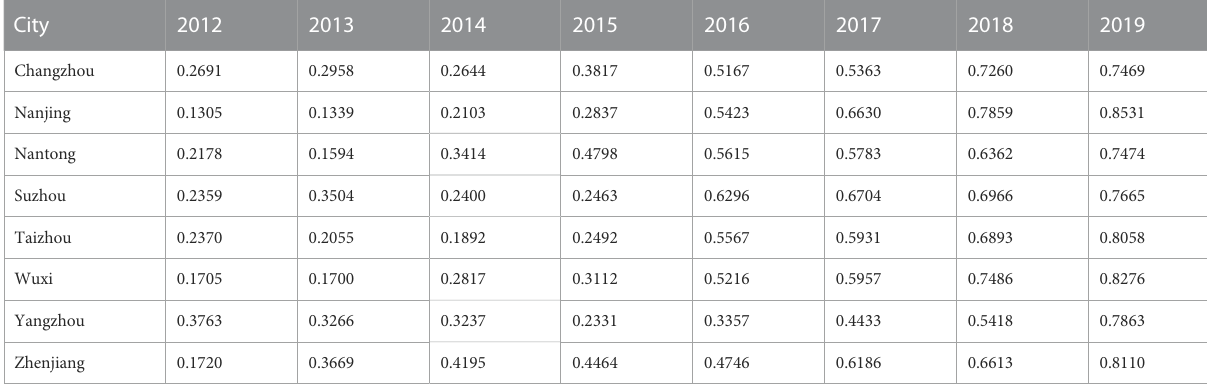
TABLE 11 Water environment carrying status index of eight cities along the Yangtze River in Jiangsu Province from the city view by the integrated method. City